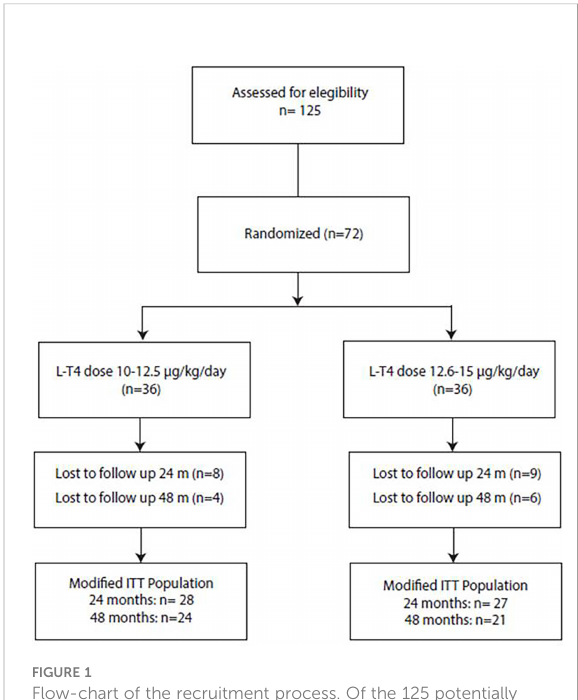
FIGURE 1 Flow-chart of the recruitment process. Of the 125 potentially recruitable patients with CH 53 were excluded because did not ful fi l all inclusion and exclusion criteria or because parents refused to participate in the study. Thus, 72 patients were enrolled in the study and randomised in the two treatment groups. During the follow up period, 17 patients drop out from the study before 24 months of life and additional 10 were lost to follow up after 24 months. Thus, the modi fi ed ITT population consisted of 45 patients followed longitudinally in the fi rst 4 years of